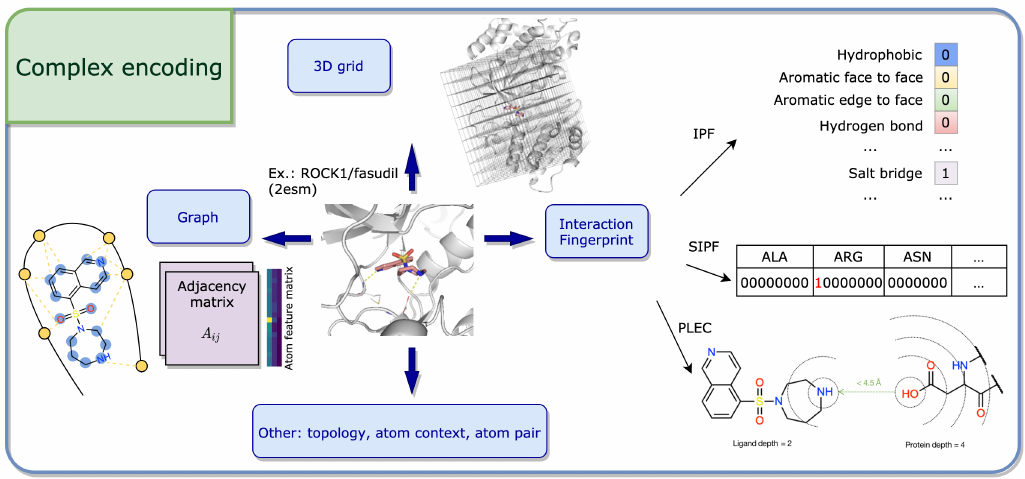
Figure 3. Complex encoding. Visual representation of encodings for protein-ligand complexes used in structure-based virtual screening, exemplified with the drug Fasudil co-crystallized with the ROCK1 kinase (PDB ID: 2esm). 3D grids, graphs and interaction fingerprints are among popular encodings for complexes, as discussed in Section